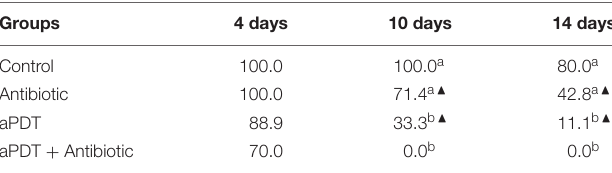
TABLE 3 | Rate of detection of bacteria in blood cultures at 4, 10, and 14 days after infection ( ¯ x + s ).